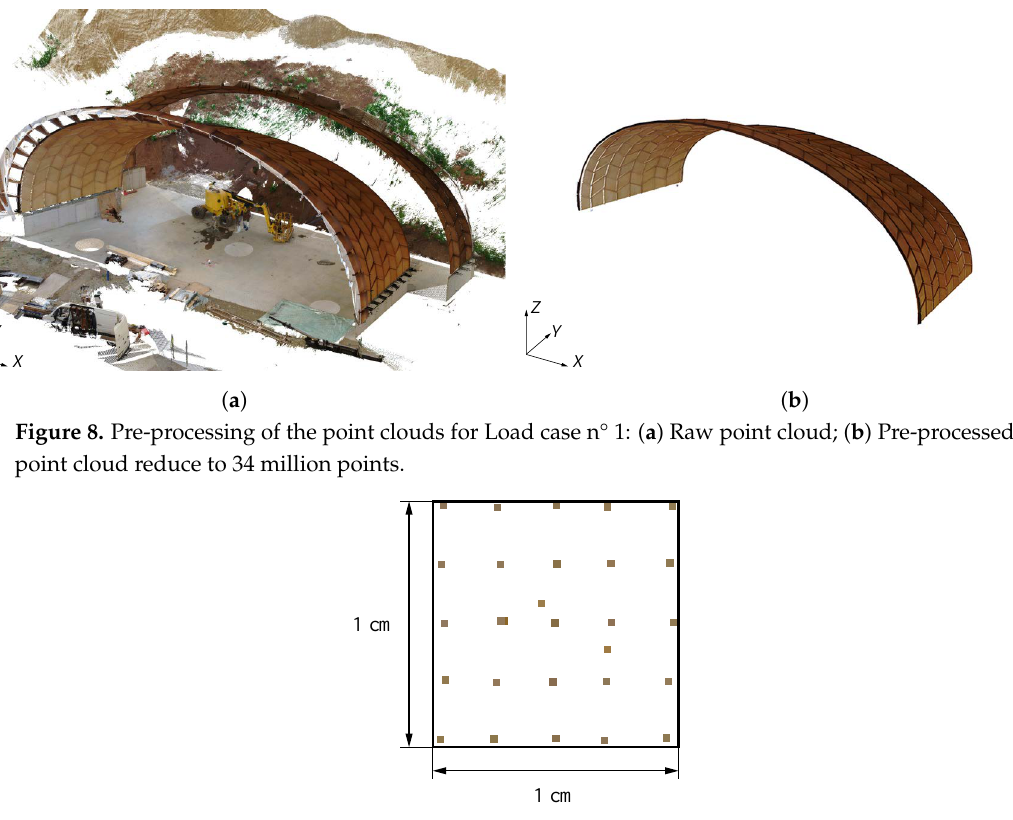
Figure 9. Area of 1 × 1cm extracted from the pre-processed point cloud of Load case n°